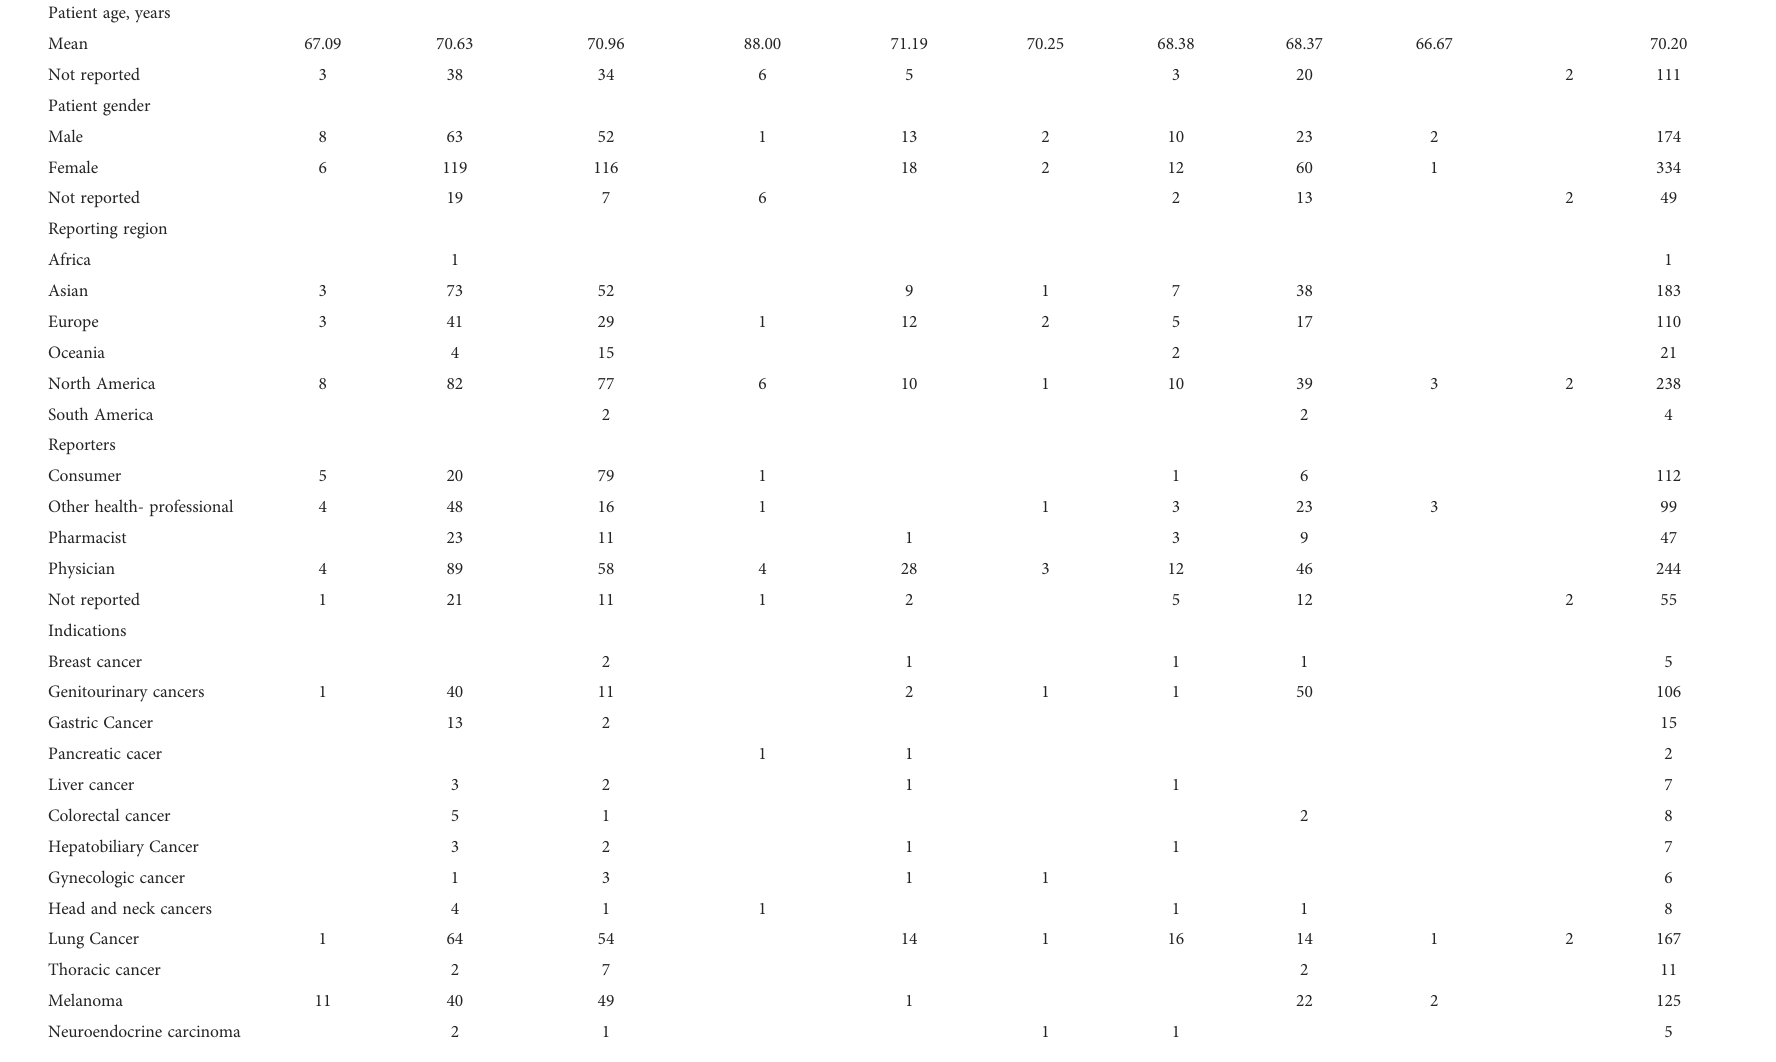
TABLE 3 Clinical characteristics of